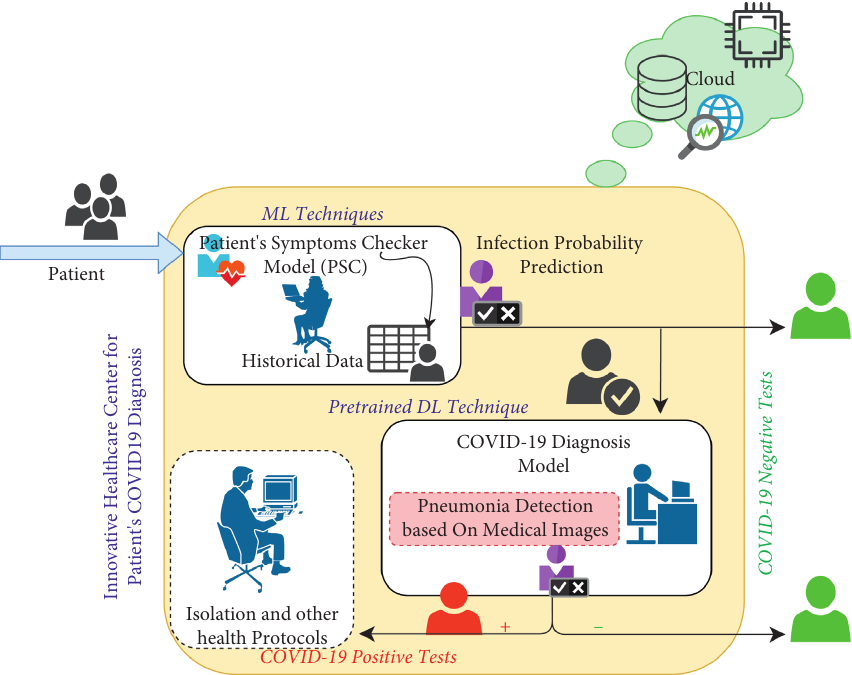
Figure 1: Proposed healthcare center for patient’s COVID-19 diagnosis.